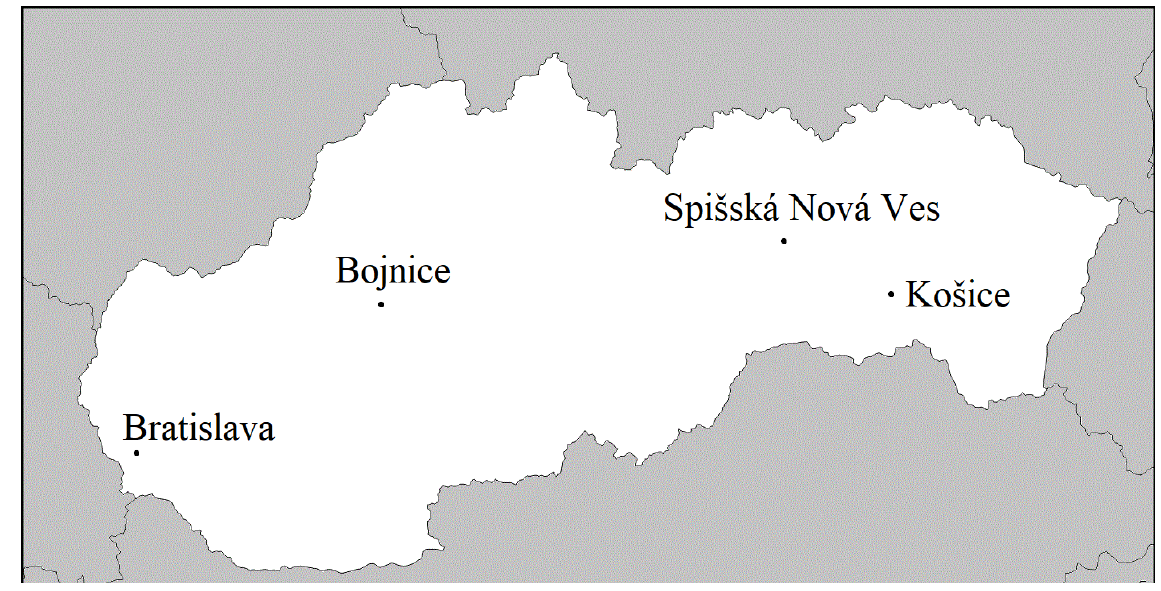
Figure 1. Map of the four Slovak zoos. Table 1. Reported number of species in the four Slovak